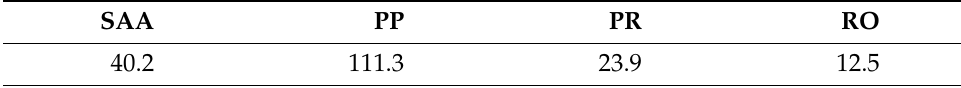
Table 2. Average out-of-sample performance ( k = 10).